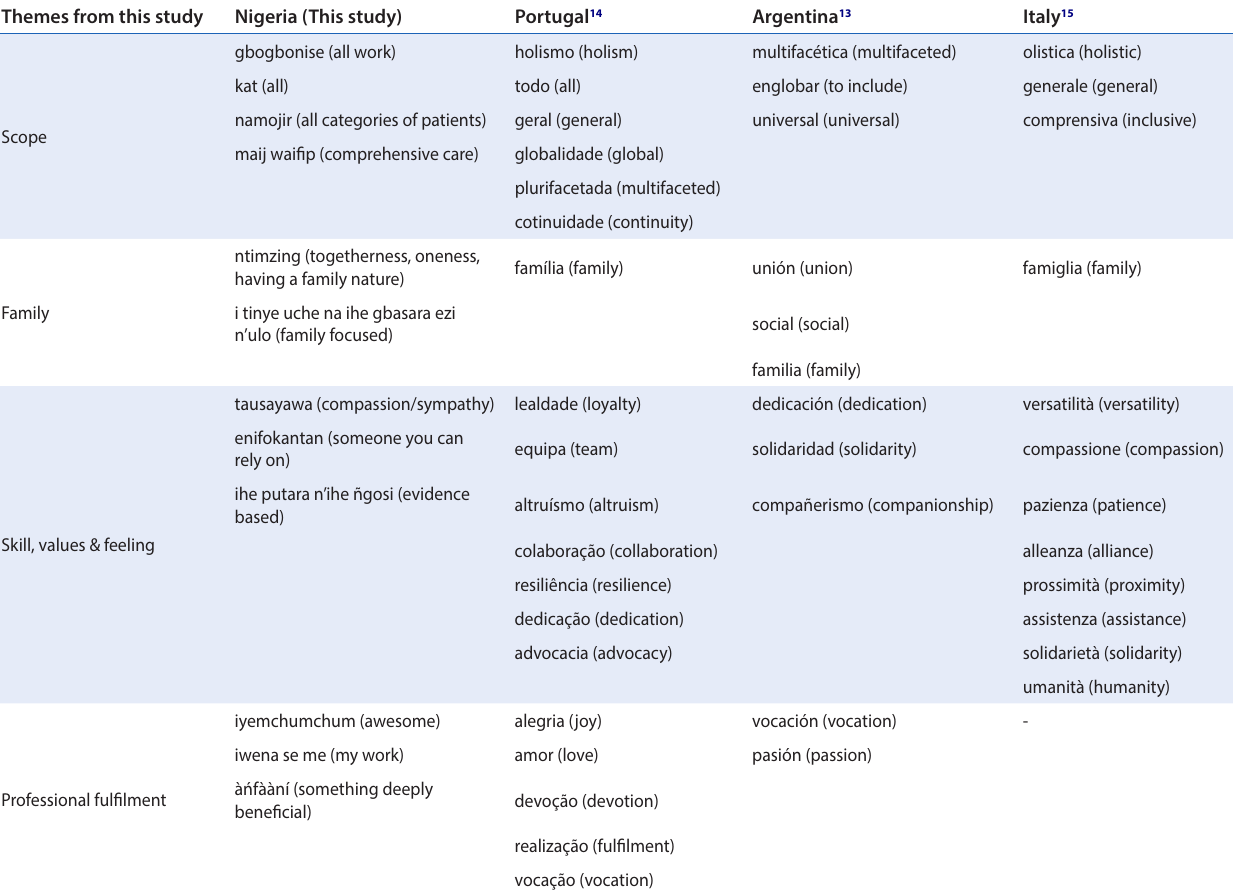
Table 1: Similarities between themes from the Nigerian study and responses from other countries participating in #1WordforFamilyMedicine Themes from this